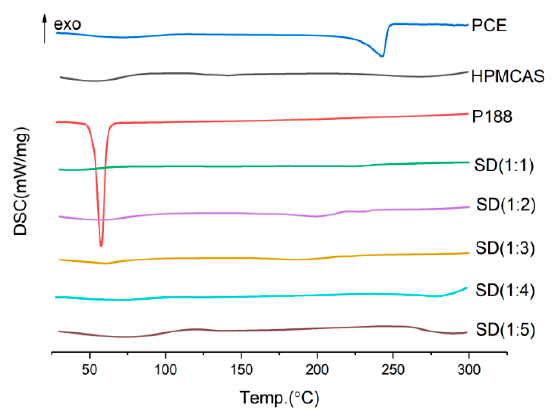
Figure 6. Dissolution curves of solid dispersion prepared by different cooling temperature.